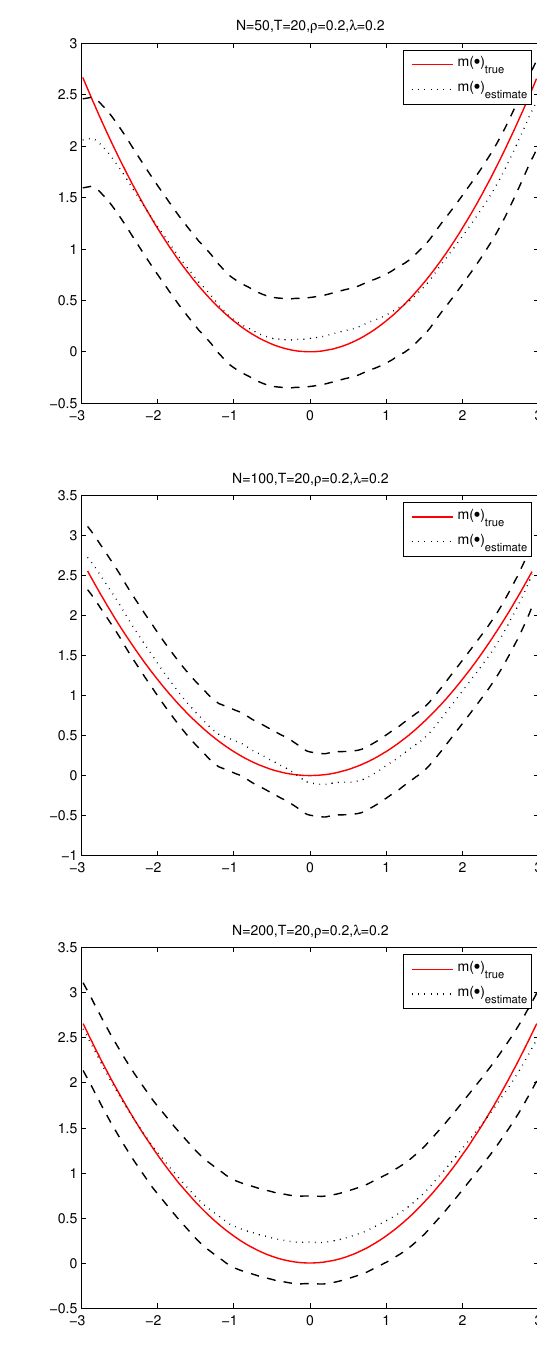
simulations ˆ m ( z ) by PQML method, the red solid line is the true values of m ( z ) , and the two black long dashed lines are the corresponding 95% confidence bands. By observing subgraphs of Figure 2, we know that shorter dotted line is fairly close to solid line and confidence band is narrow. These mean that nonparametric estimation procedure perfor- mances well under finite sample. To save space, we do not show the others cases under ρ = 0.2 with λ = 0.4, ρ = 0.4 with λ = 0.2 and ρ = 0.4 with λ = 0.4 of different N and T because they are similar with the case ρ = 0.2 with λ = 0.2.